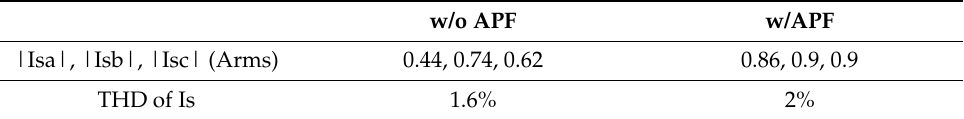
Table 11. Magnitudes and THD of the source currents.